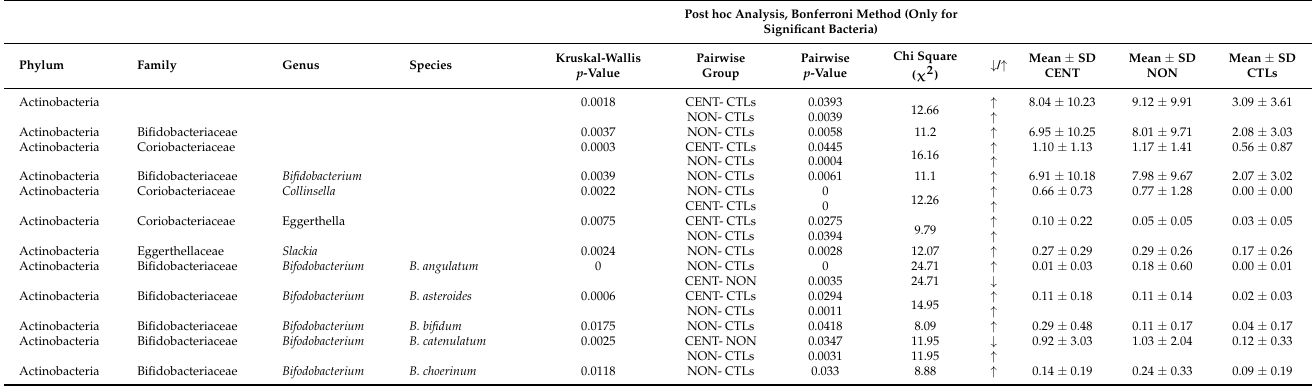
Table 4. Statistically significant differences in the relative abundance of bacterial taxa between CENT, NON and